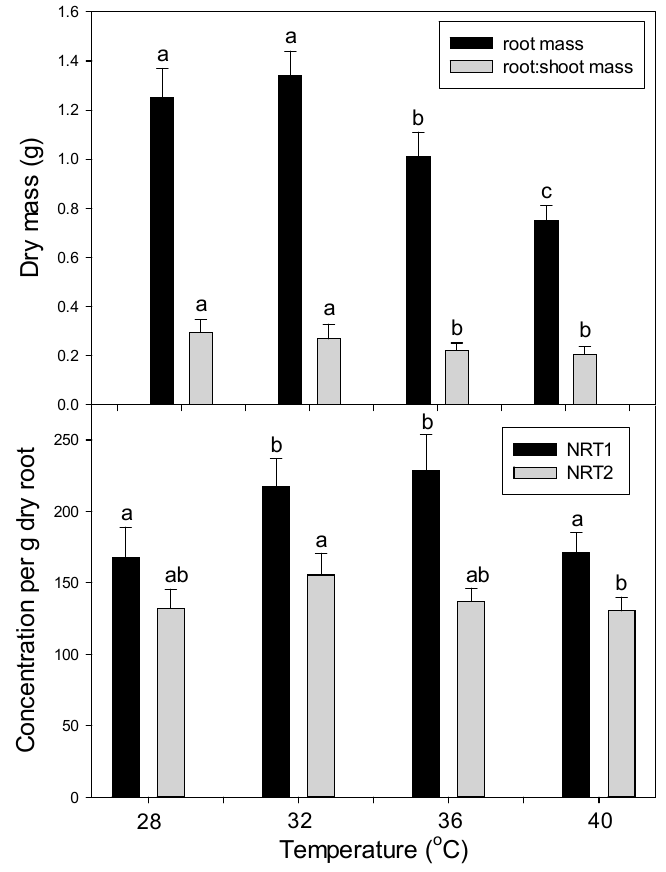
Figure 9. Effect of chronic heat stress on (top panel) plant growth and (bottom panel) relative levels of the nitrate-uptake proteins, NRT1 and NRT2 (per g dry root), in roots of tomato. Plants were grown at 28 ◦ C/23 ◦ C, 32 ◦ C/27 ◦ C, 36 ◦ C/31 ◦ C, or 40 ◦ C/35 ◦ C (day/night) for 15 days. Values are means ± 1 SE for four independent replicates. Different lowercase letters indicate significant difference among temperature treatments within each response variable.